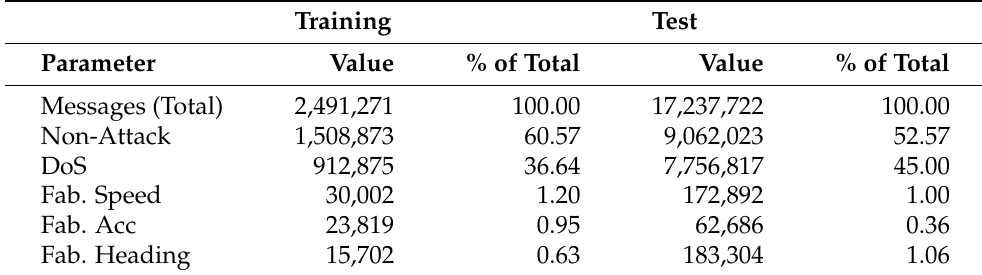
Table 4. Contents of the test and training datasets per message